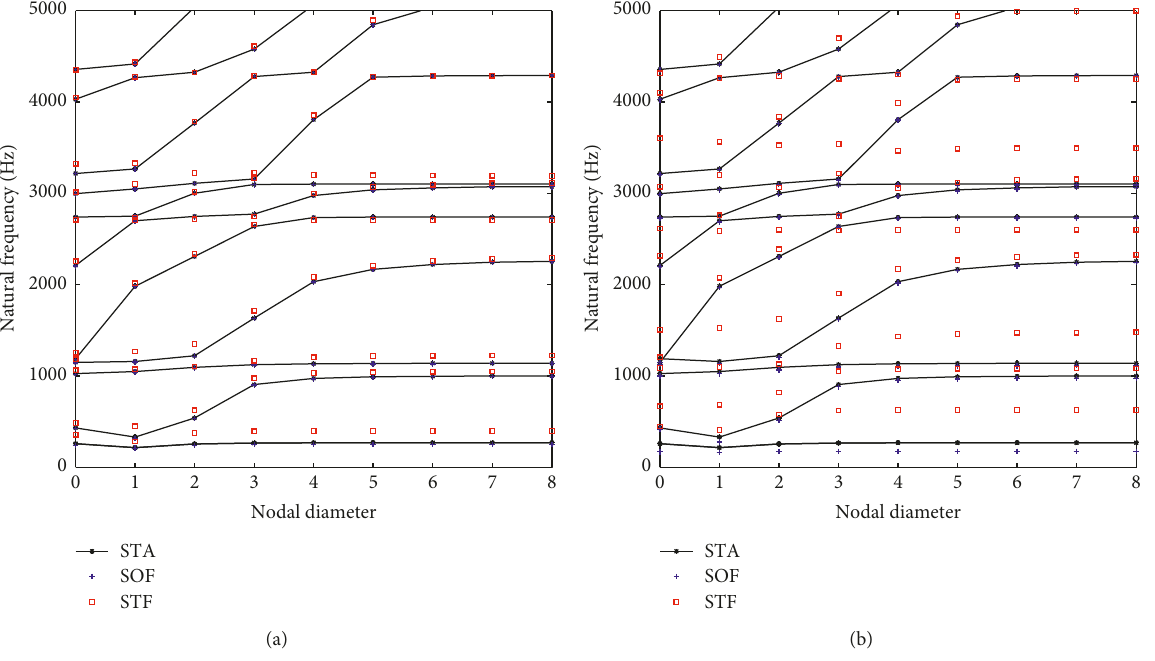
Figure 2: Natural frequencies versus the number of nodal diameters of the STA, SOF, and STF cases: (a) Ω � 1000rad/s. (b) Ω �